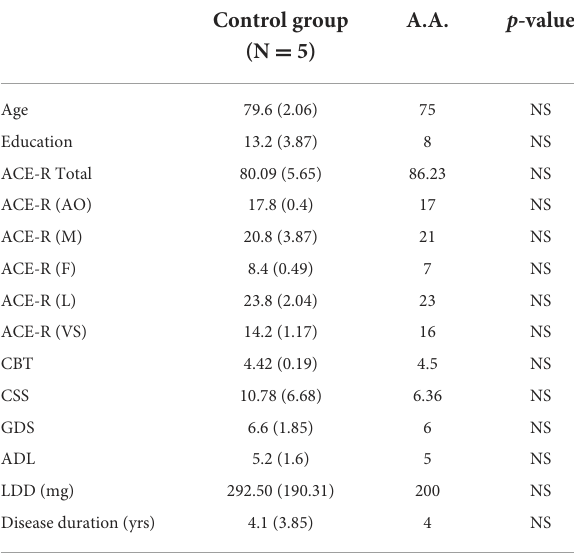
TABLE 1 Summary of demographics and clinical